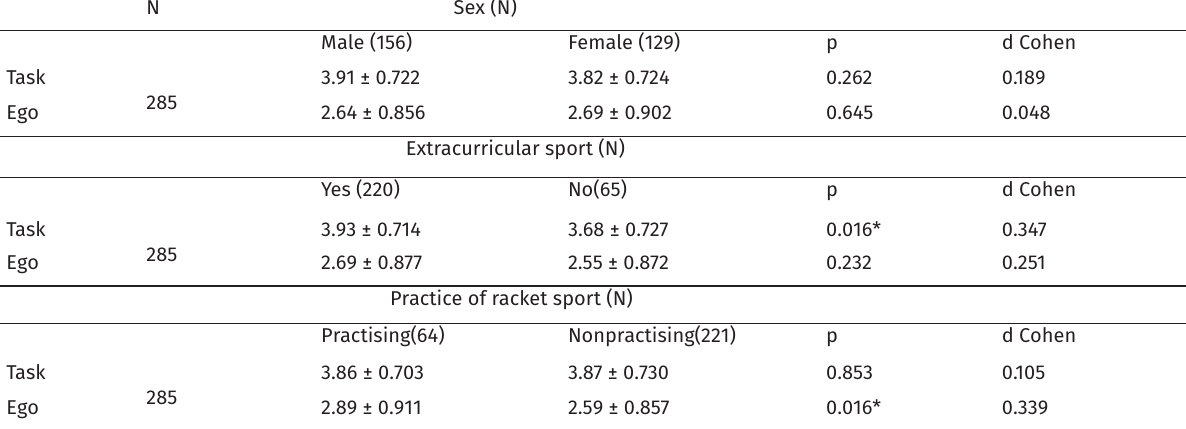
Table 1. Comparison of task and ego involved based on gender, sports practice outside school and racket sports practice of all the